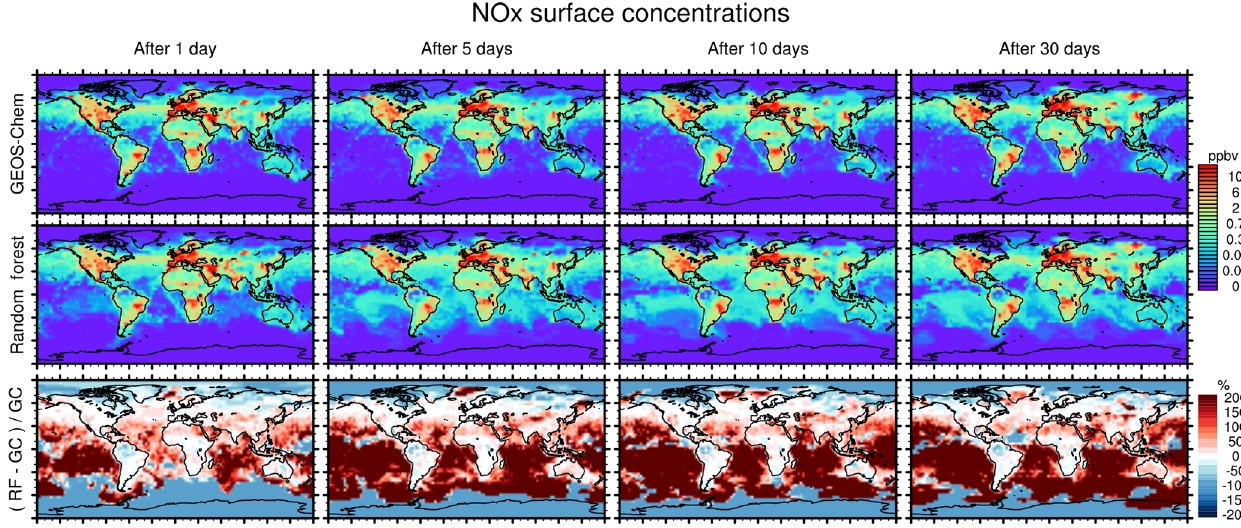
Figure 8. Concentration maps of surface NO x (NO + NO 2 ) after 1 simulation day (column 1), 5 simulation days (column 2), 10 simulation days (column 3) and 30 simulation days (column 4), as calculated by the full GEOS-Chem model (row 1) and the standard random forest (RF) model with the NO x family treatment (row 2). Row 3 shows the percentage difference between the RF simulation and GEOS-Chem (GC).